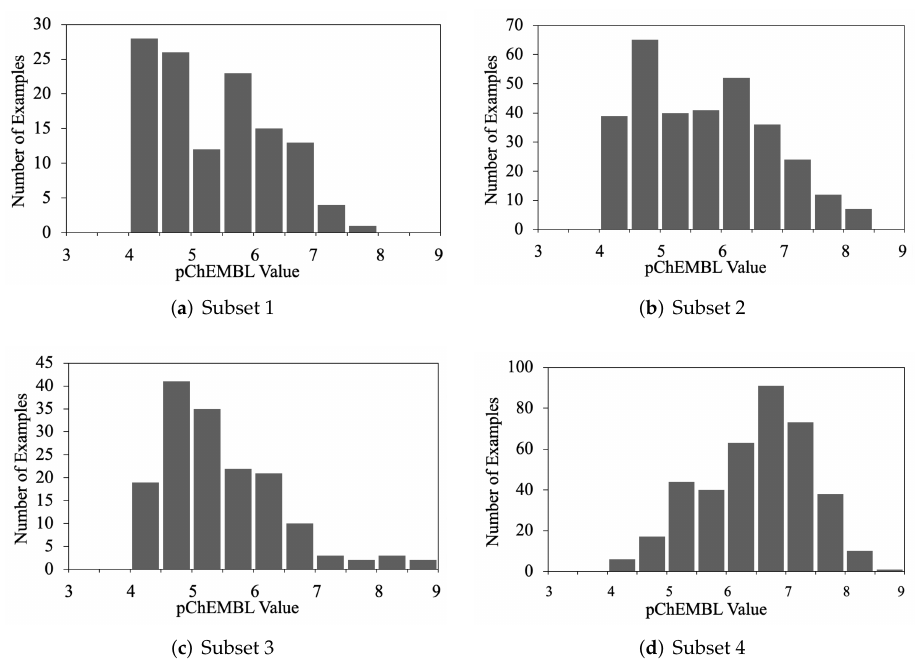
Figure 5. Distribution of the activities in each subset. ( a ) Subset 1: guanidine and thiourea derivatives. ( b ) Subset 2: five or six-membered heterocyclic compounds. ( c ) Subset 3: styrene derivatives. ( d ) Subset 4: tranylcypromine (TCP)